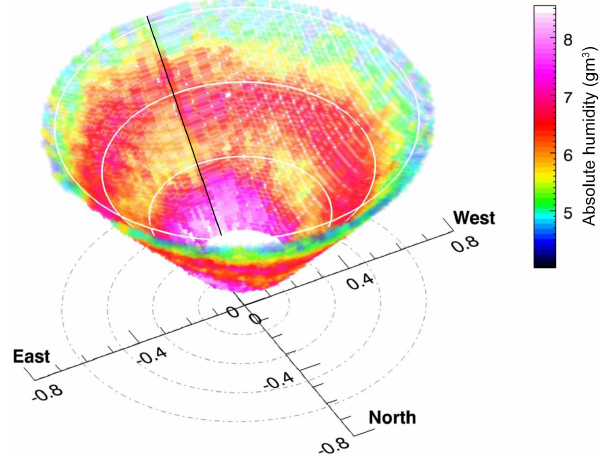
Figure 8. Conical scan of SOP 2 on 22 August 2014 between 08:40 and 08:55 UTC. The cone has an elevation angle of 50 ◦ . The data were plotted for a height range from 0.2 up to 0.8kma.g.l. The white circles indicate the height in 0.2km steps and the grey dashed- pointed circles show their projection down to the ground. The black solid line marks the start and end direction of the conical scan; the scanner unit moved clockwise. The scales are given in km.